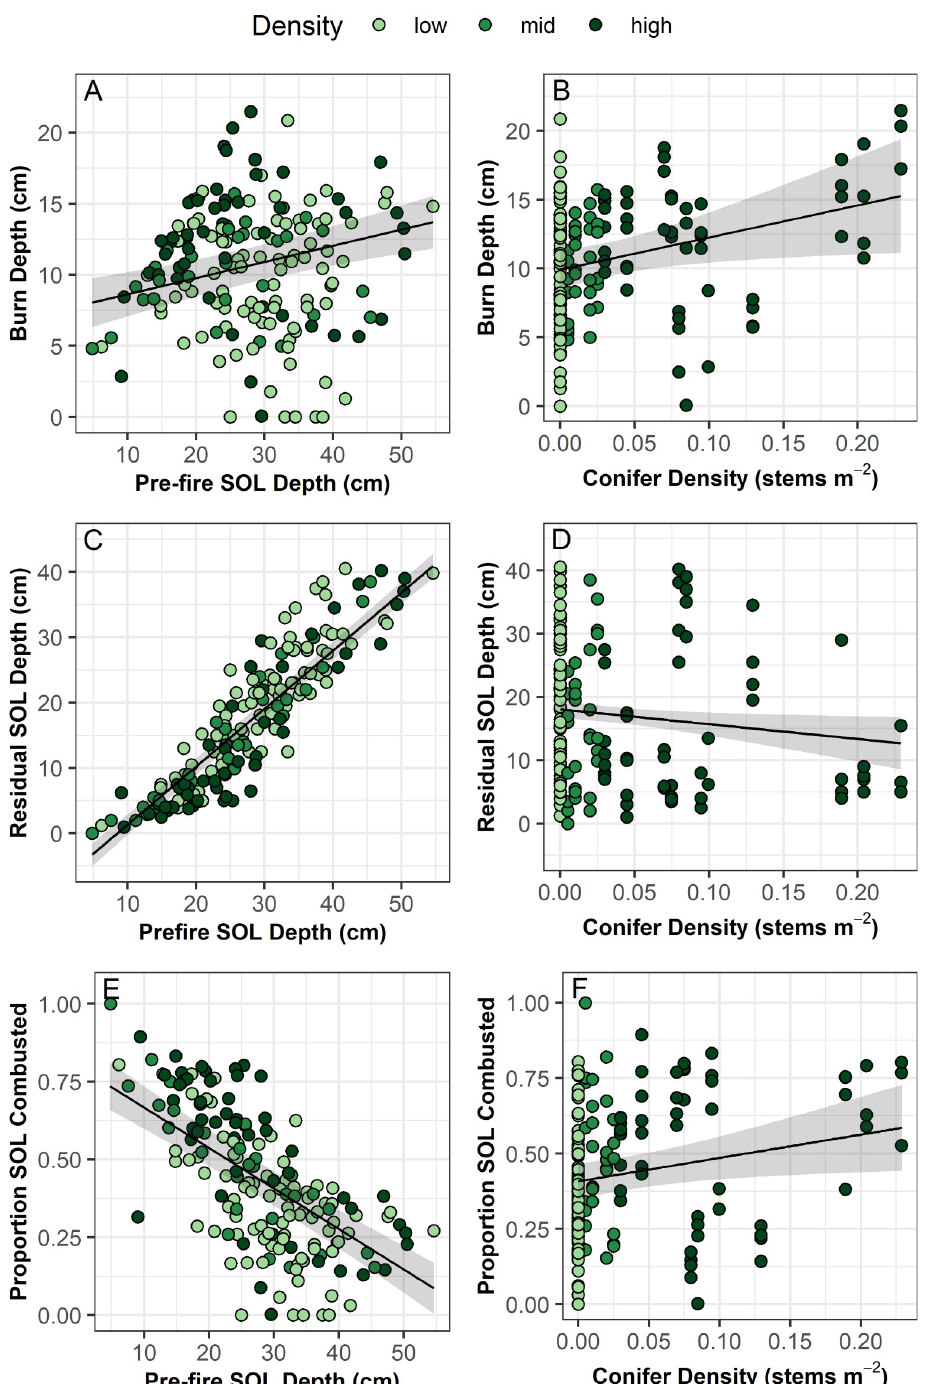
Fig 3. Burn depth, residual soil organic layer (SOL) depth, and proportion of pre-fire SOL combusted as a function of pre-fire SOL depth and conifer density. Black lines represent modelled relationships from linear mixed effects models with random effects of grid (2 levels) and plot (46 levels) nested within grid. Shading represents 95% confidence regions. See Table 2 for model results.